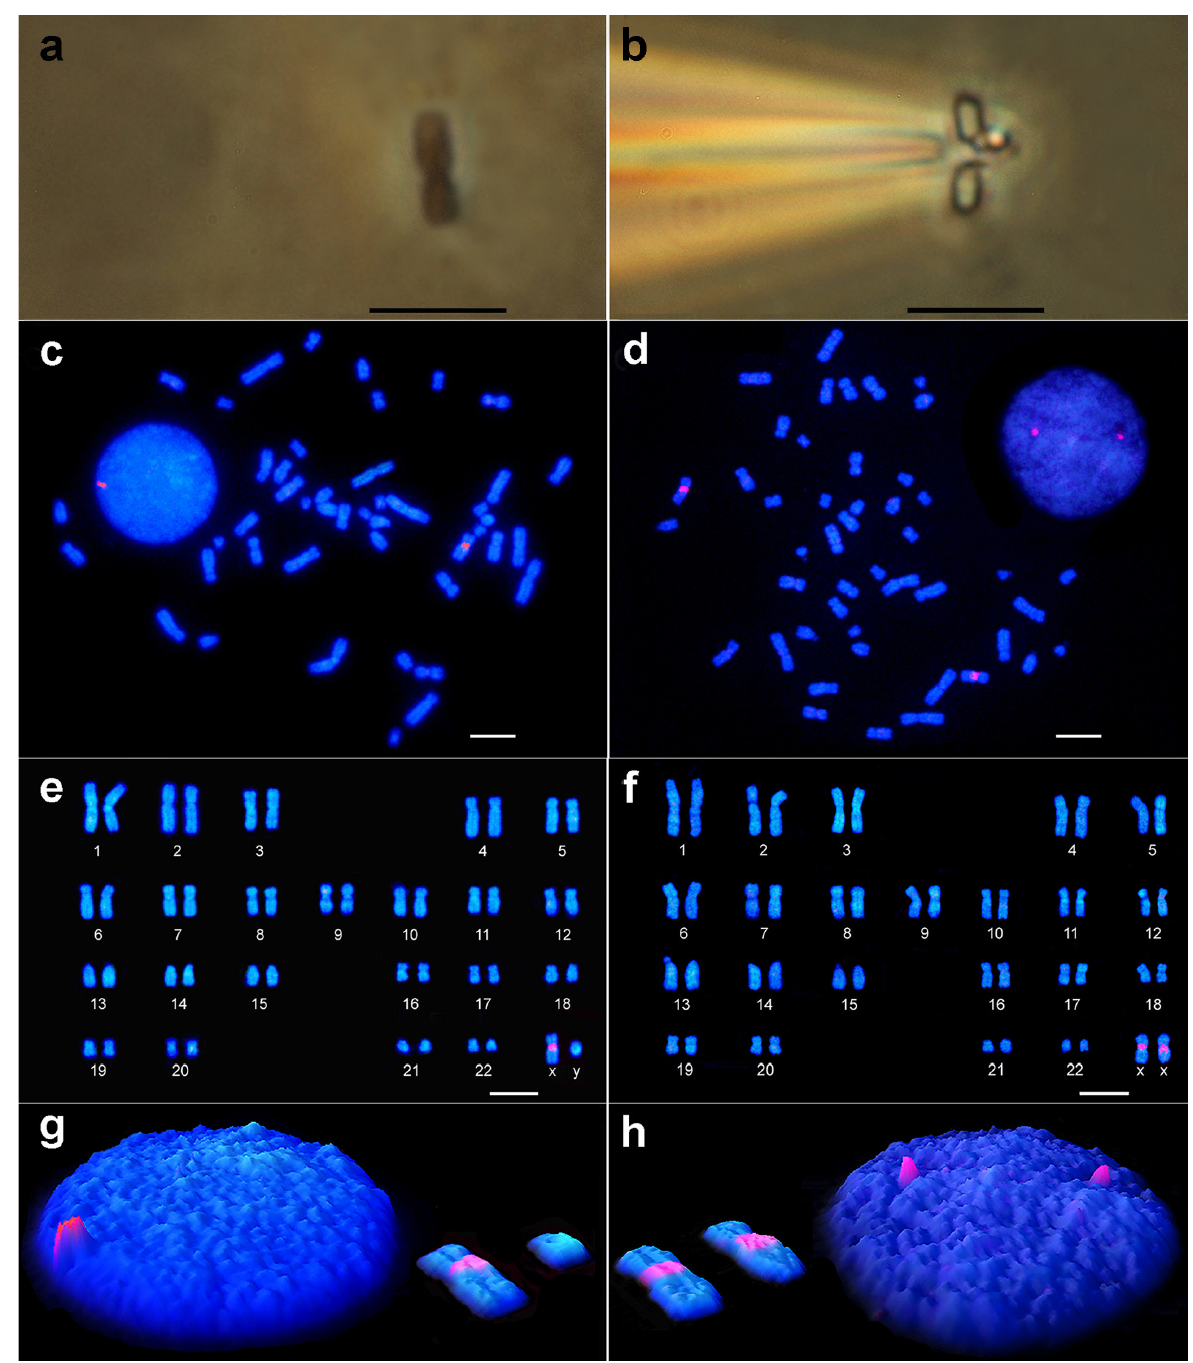
Figure 1 - Microdissection procedure and FISH using chromosome-specific probe obtained via DOP-PCR. Microdissection procedure ( a ) before and ( b ) after removal of the chromosome fragment. Probe hybridization in the X chromosome in metaphase of ( c ) male and ( d ) female individuals, counterstained with DAPI. Note the red fluorescent spots in the X chromosomes and nuclei. ( e ) Male and ( f ) female karyotypes showing the marks on the X chromosomes. ( g , h ) 3-D plots of the nuclei and sexual pair highlighting the positive signals. Bar = 10